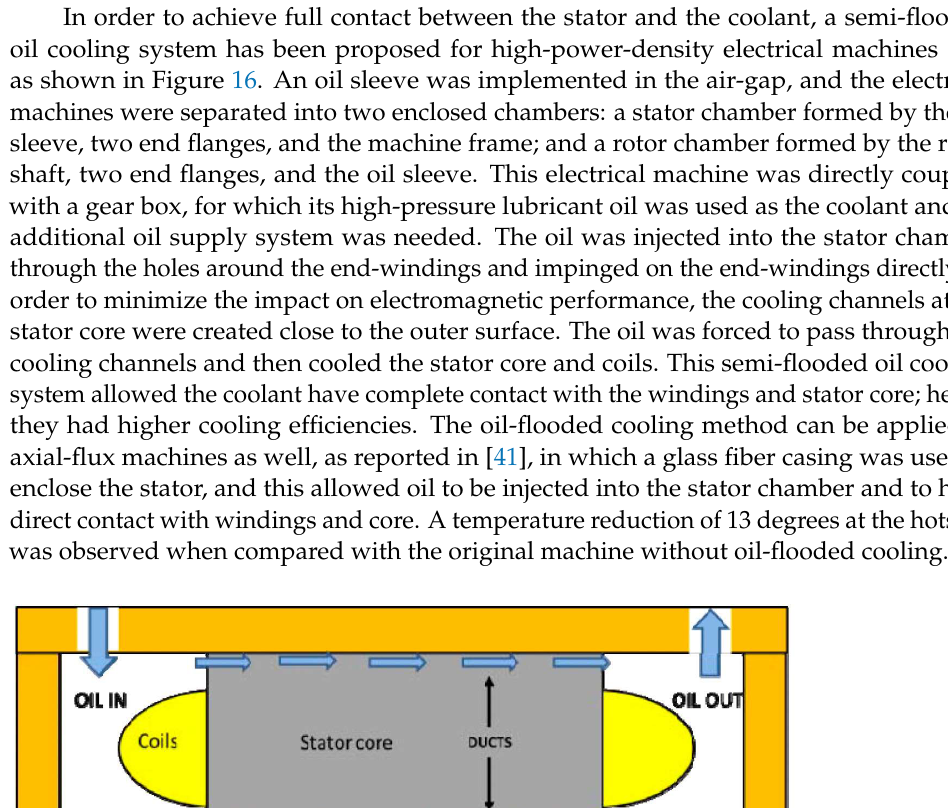
( b ) Figure 17. Schematic of the direct oil cooling for the end-winding [42]. ( a ) Slot configuration; ( b ) axial cross section. Recently, hairpin windings have attracted increasing attention in electric vehicle propulsion areas due to the advantages of a high-fill factor, reduced manufacturing time, and shorter end-windings. The conductors of hairpin windings are precisely arranged, and the gap between the conductors of end-windings is regularly and accurately defined. This geometric feature introduces new challenges and opportunities for heat dissipation. Oil spray cooling is ideal for the cooling of hairpin windings, which can achieve a good balance between the heat dissipation, fluid inventory, and robustness. Figure 18 shows two examples of oil spray cooling. The oil can be injected through the nozzle close to the